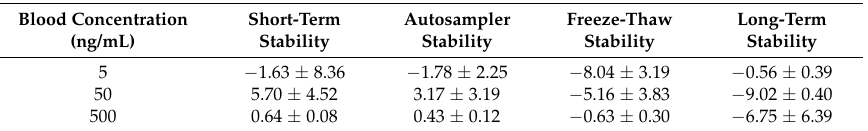
Table 3. The stability data for schizandrin in rat